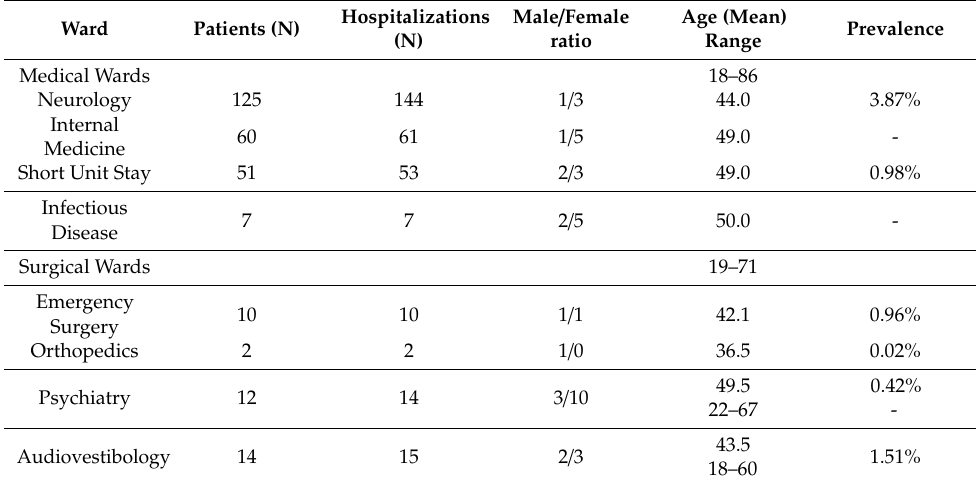
Table 2. Distribution of patients with Medically Unexplained Physical Symptoms (MUPS) in hospital wards.